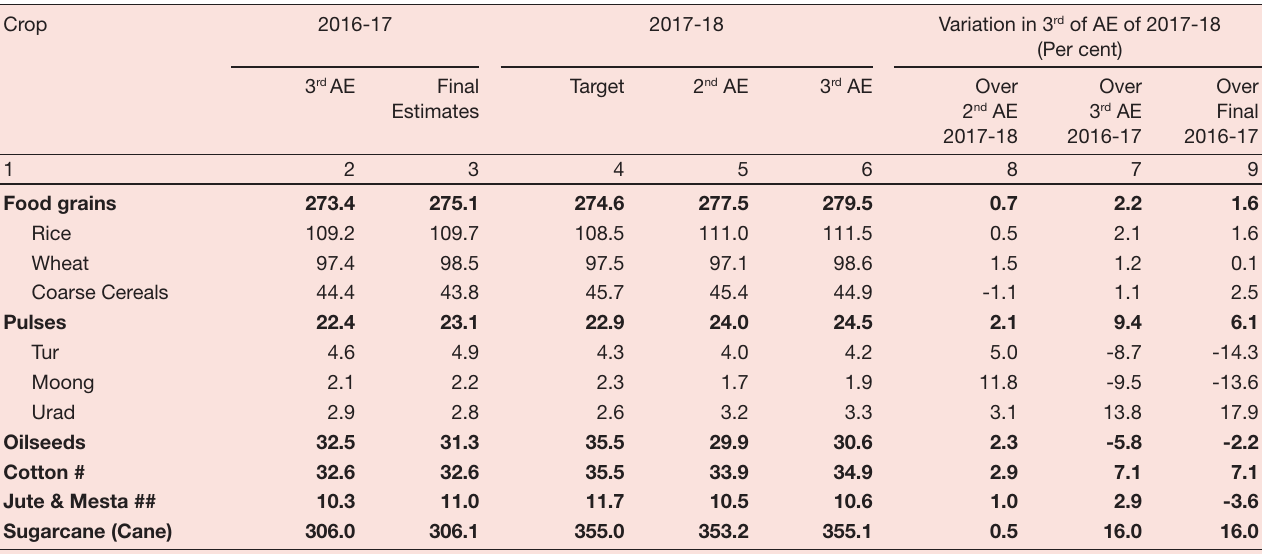
Table II.1.3: agricultural Production